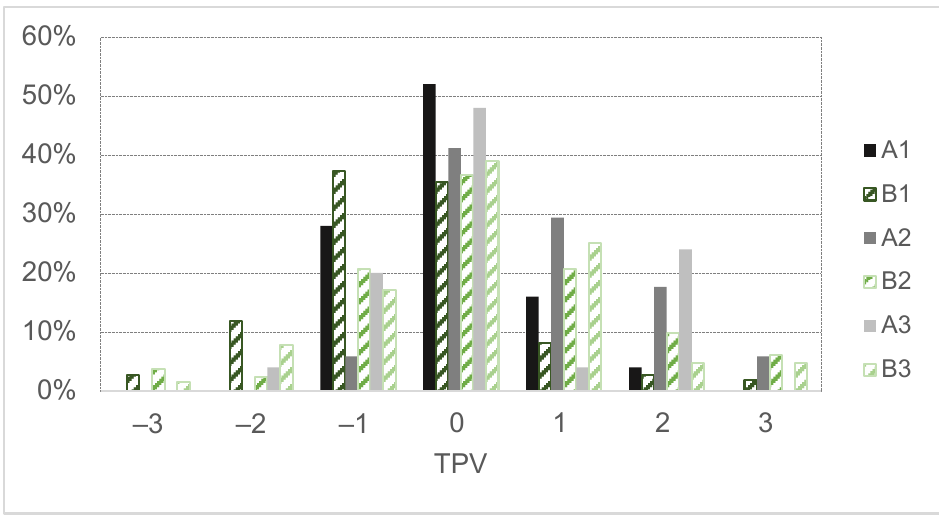
Figure 6. Relative frequency of TPV for both groups (A and B)—three survey days. On the first day of the survey in the B group, room occupancy was 37% (Table 2) and indoor and outdoor temperature values were the highest, TSV were also the highest. The mean TSV was 0.97. On the second day of mid-term measurements for the A group, when the auditorium load was the lowest (only 6%), the room temperature was also the lowest of 21.1 °C, and the mean TSV was − 0.24. It was the only case where TSV took a negative value and more than 50% of the students expressed a desire to increase the room temperature (Figure 5 and Table 5). In winter, in January (the third test day), the evaluation of TSV for the B group was higher than for the A group, while the TPV was adequately lower. The responses for all six subgroups about sensations: TSV, AfSV and preferences: TPV, AmPV, and RHPV are summarized in Table